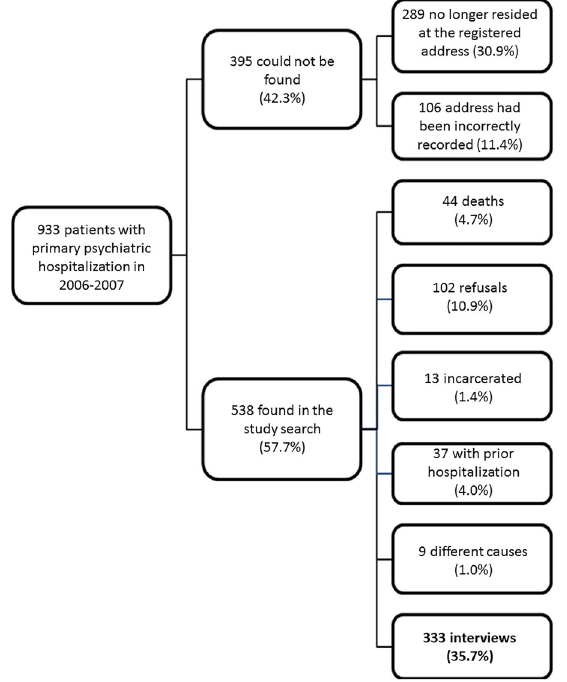
Figure 1. Flowchart of the patients enrolled in the